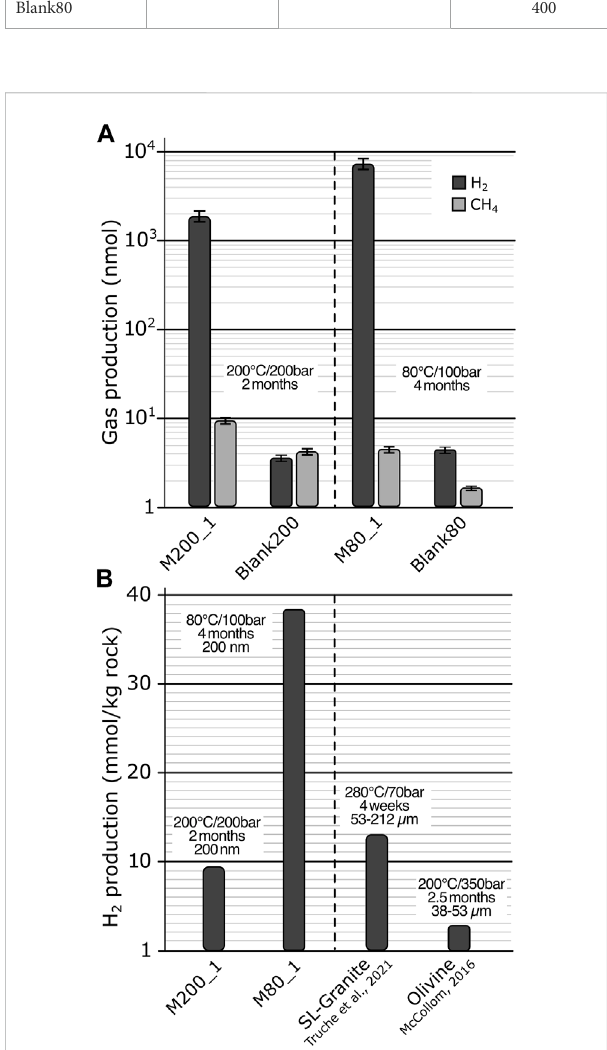
FIGURE 2 (A) H 2 and CH 4 generation from magnetite and blank capsules, obtained after gas chromatography and expressed in nmol. Uncertainties are given in percentage of the measurements, ±14% for H 2 and ±8% for CH 4 . (B) Results are compared to similar experiments on olivine (McCollom, 2016) and ferrous granite from Strange Lake, Canada (Truche et al.,